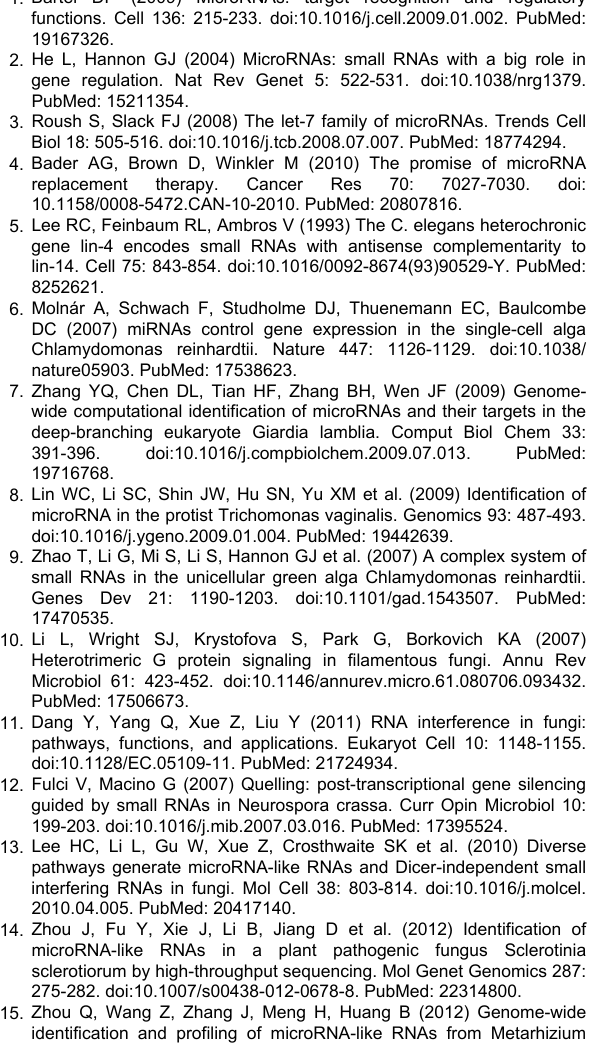
Table S4. Predicted targets of T. reesei